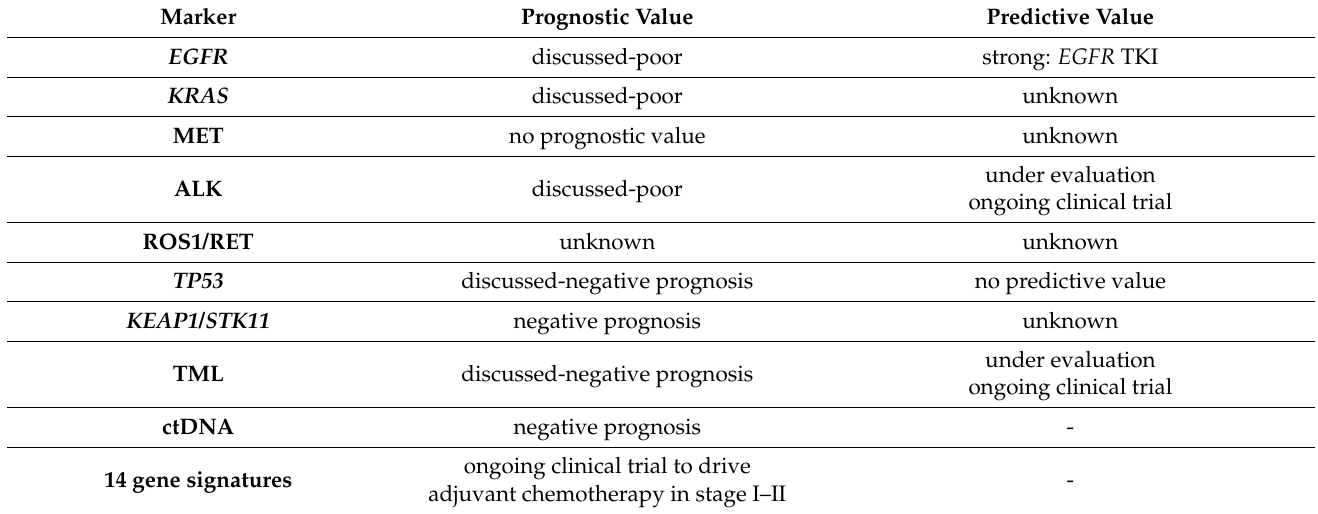
Table 3. Prognostic and predictive values of molecular features in resected lung